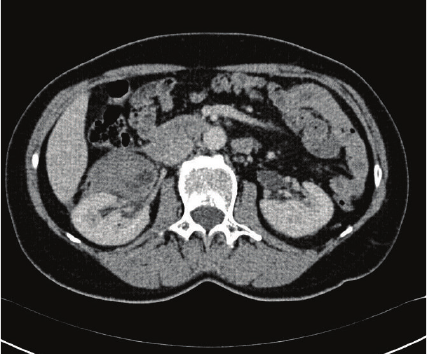
Figure 3: CT scan revealed a right perirenal hematoma after the rupture of the renal angiomyolipoma.